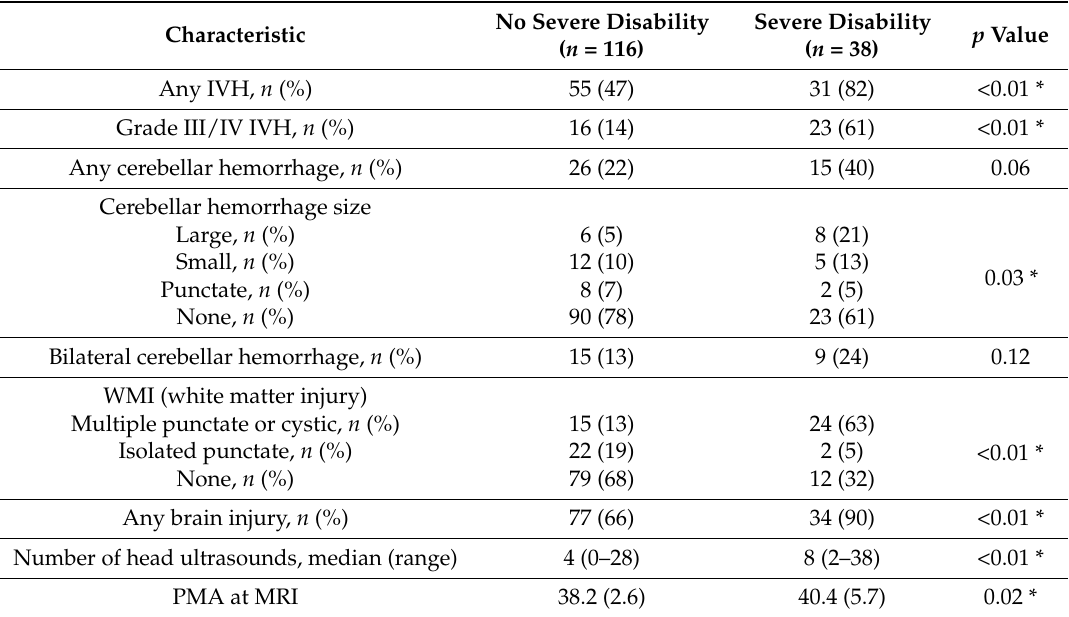
Table 3. Imaging Characteristics.